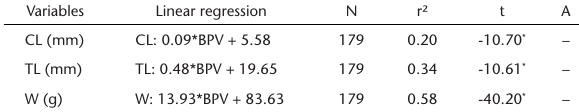
Table 3. Relationship between brood pouch volume (BPV) and morphometric data in ovigerous females of the Palaemon pandal- iformis sampled in Rio Salsa, Canavieiras, Bahia, Brazil. (CL) Cara- pace length, (TL) total length, (W) total weight, (r 2 ) coefficient of determination, (A) allometry, (*) statistically significant at p ≤